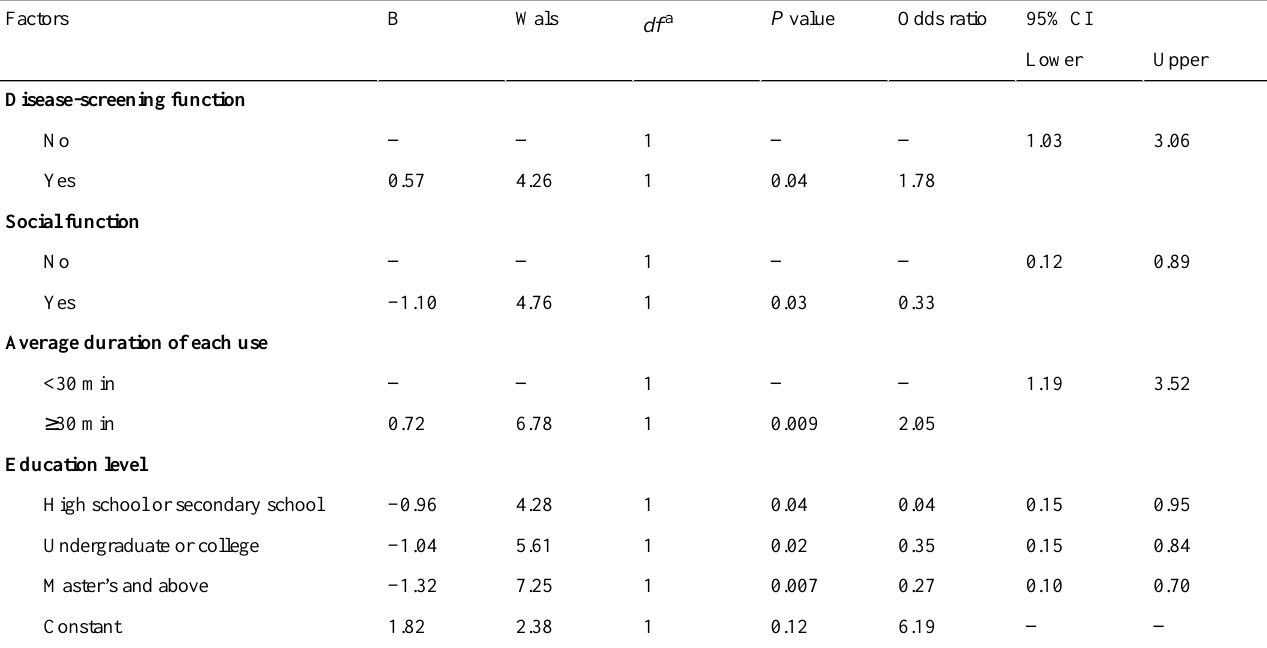
Table 7. Factors influencing antenatal